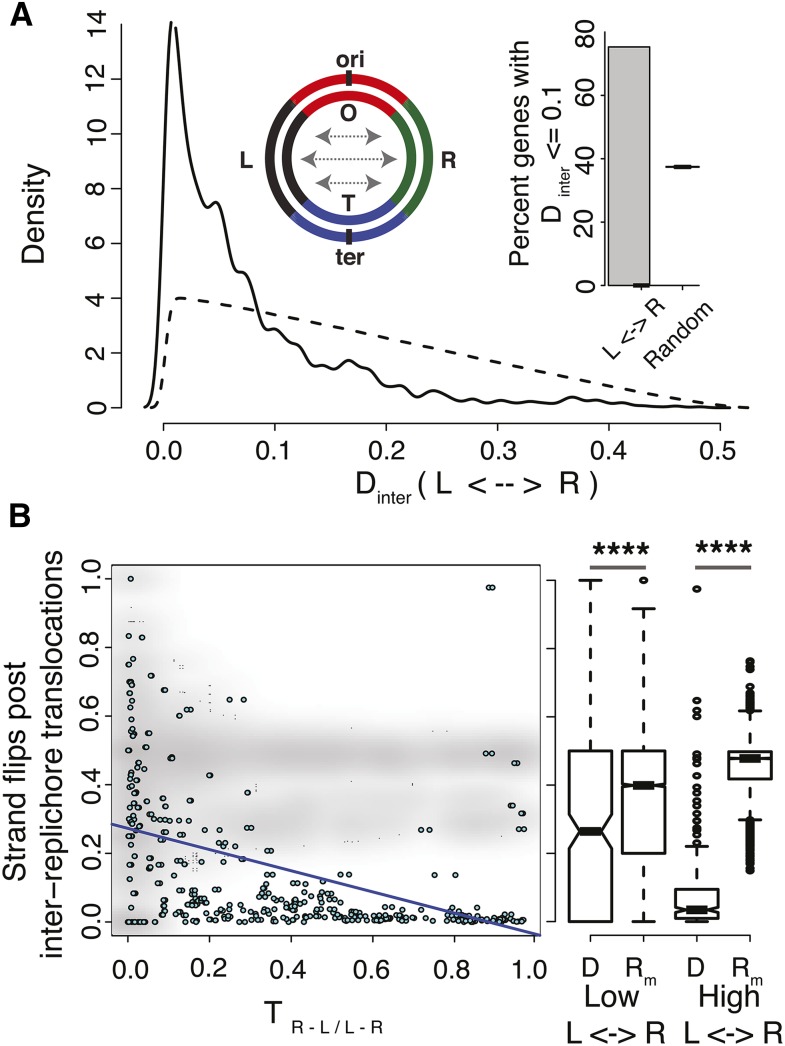
Selective value of chromosome topology. (A) Plot representing the distribution of Dinter = |dR/L – dL/R| for all bacteria showing high interreplichore translocations (TL−R/R−L > 0.1). Dashed line indicates the distribution of Dinter for randomized datasets (as described in Materials and Methods), similar to the inner panel of Figure 4B. Inner panel shows the percentage of gene pairs with Dinter < 0.1 for all bacteria showing high interreplichore translocations, alongside random expectation (determined from randomized datasets as described in Materials and Methods). (B) Plot representing the proportion of leading-lagging strand flips post interreplichore translocations as a function of the proportion of interreplichore translocations (ρSpearman = 0.17, P-value < 10−10) in cyan. A randomized dataset (as described in Materials and Methods) is shown in gray. Adjacent bloxplot represents the distribution of leading-lagging strand flips in bacteria with high and low interreplichore translocations alongside random expectation (Rm) for each dataset (D) (low TL−R/R−L, P-value = 2.9 × 10−6, Wilcoxon test and high TL−R/R−L, P-value < 10−10,Wilcoxon test). Asterisks indicate P-value < 10−3.